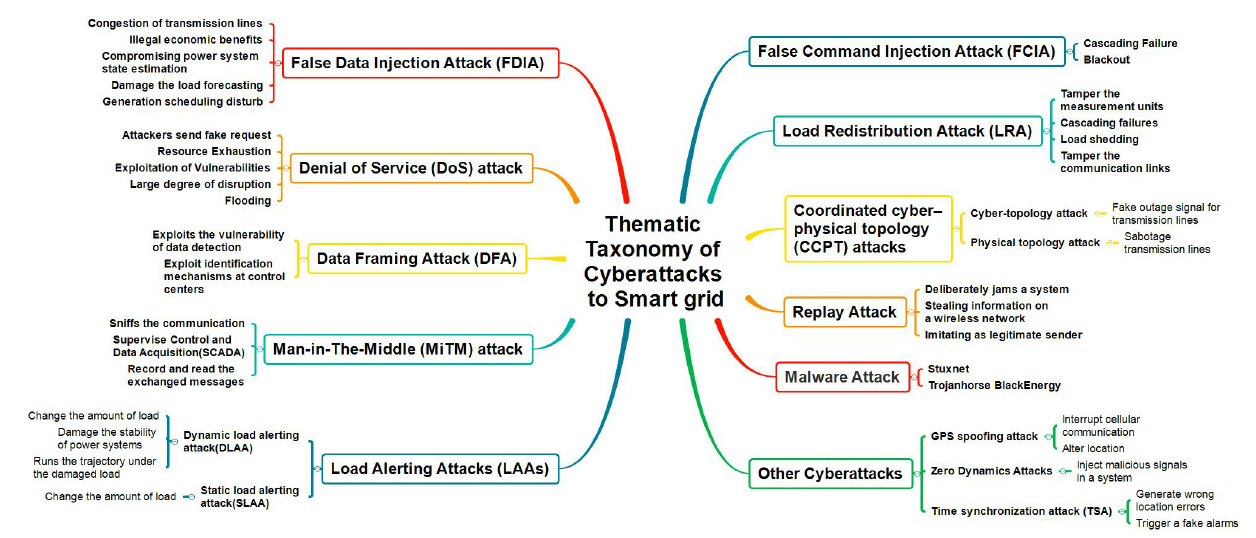
Figure 4. Thematic taxonomy of cyberattacks to smart